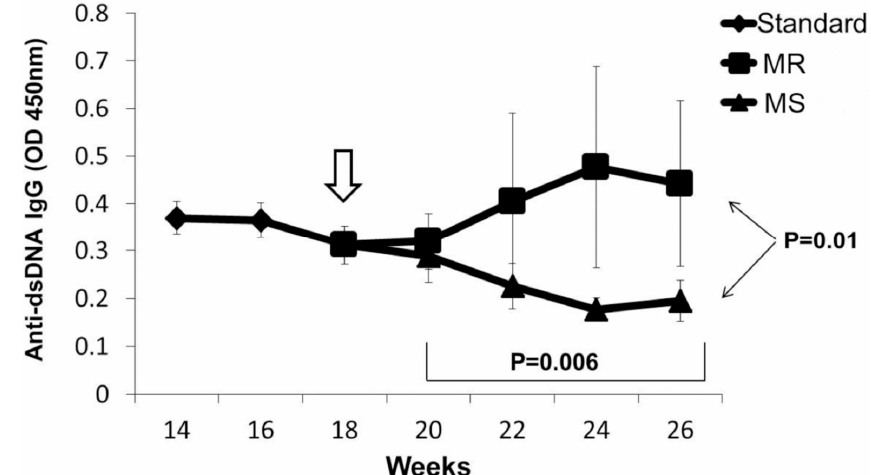
Figure 3. Anti-dsDNA IgG Antibody Levels Decline in DOX-Treated Transgenic Mice Fed the MS Diet. Standard diet weeks 14–18 vs. MS diet weeks 20–26, p = 0.006 (linear regression); Standard diet vs. MR diet p = 0.368 (linear regression). MS vs. MR diet, week 26, p = 0.01.